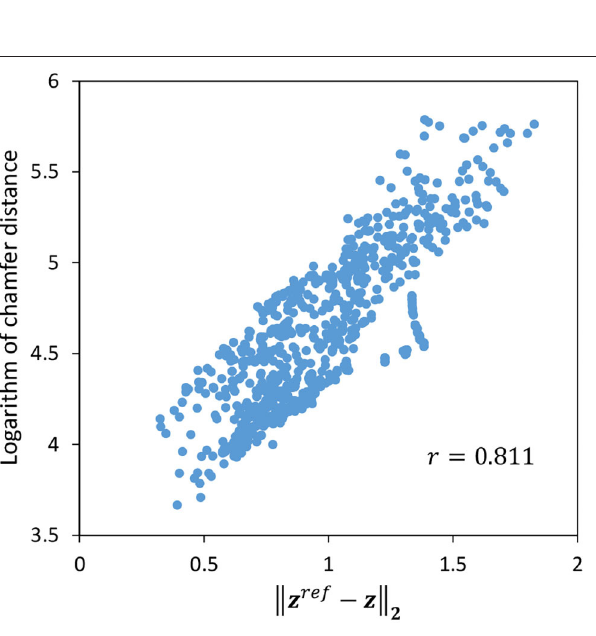
two values are well correlated, with a correlation coefficient of